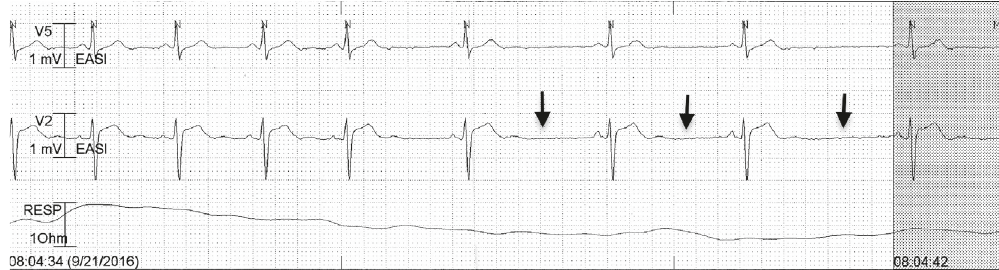
Figure 2: Telemetry monitor strips showing frequent sinus pauses (arrows) preceding the asystole.